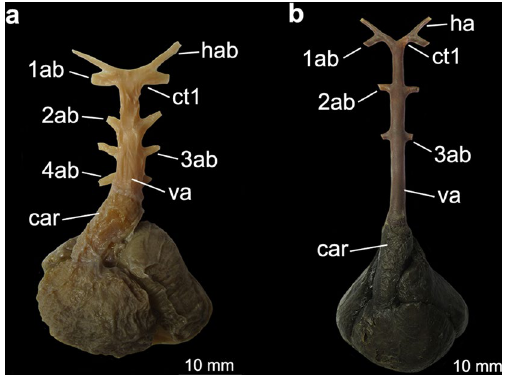
Figure 2. Heart and afferent branchial arteries in Myliobatiformes. ( a ) Ventral view of Rhinoptera bonasus ; ( b ) ventral view of Mobula hypostoma , fourth branchial afferent artery not shown. 1ab-4ab 1st-4th afferent branchial arteries; car conus arteriosus ; ct1 common trunk from the ventral aorta to the hyoidean and first afferent branchial arteries; hab hyoidean afferent branchial artery; va ventral aorta.